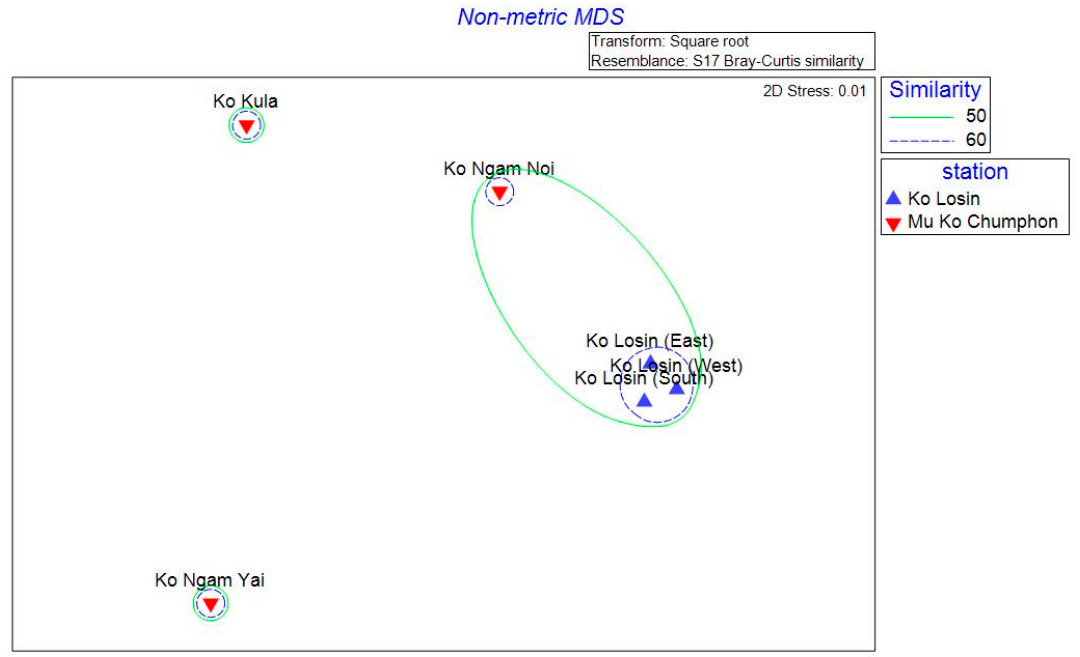
Figure 6. Two-dimensional non-metric multidimensional scaling (NMDS) plot of the taxonomic composition of corals at the study sites. Table 2. Similarity percentage (SIMPER) analysis of benthic communities in two regions in the Gulf of Thailand.